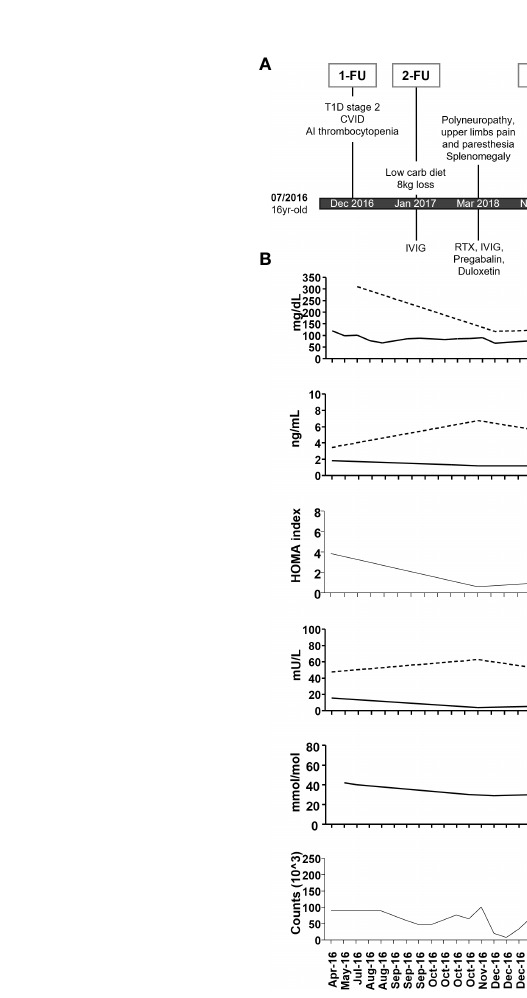
FIGURE 1 Timeline of clinical events, therapeutic interventions, and diagnostic procedures. (A) Summary of major clinical manifestations and therapeutic interventions. IVIG: intravenous immunoglobulins; SCIG: subcutaneous immunoglobulins; RTX: Rituximab. At each follow-up, an extensive immune cell phenotyping was conducted. (B) Timeline of fasting blood glucose (FBG), 2-h blood glucose (BG2h), fasting C-peptide (CPEP), and 2-h C-peptide (CPEP2h), HOMA index, fasting insulin (FI) and 2-h insulin (I2h), glycohemoglobin (HbA1c), and platelet count (PLT) from April 2016 to August